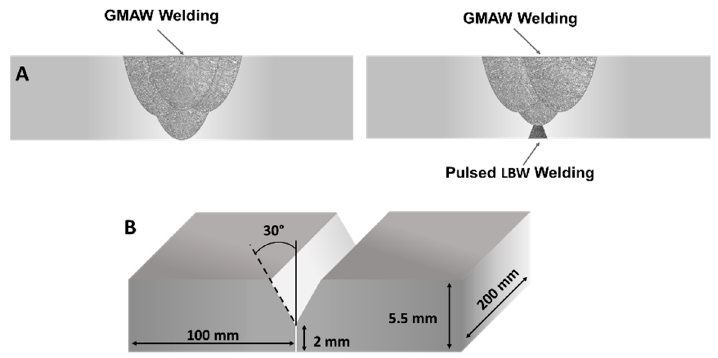
Figure 1. ( A ) Welding joints conditions: single-sided GMAW process (left image) and double-sided PL + GMAW process (right image). ( B ) Plate preparation with a Y-groove joint configuration.